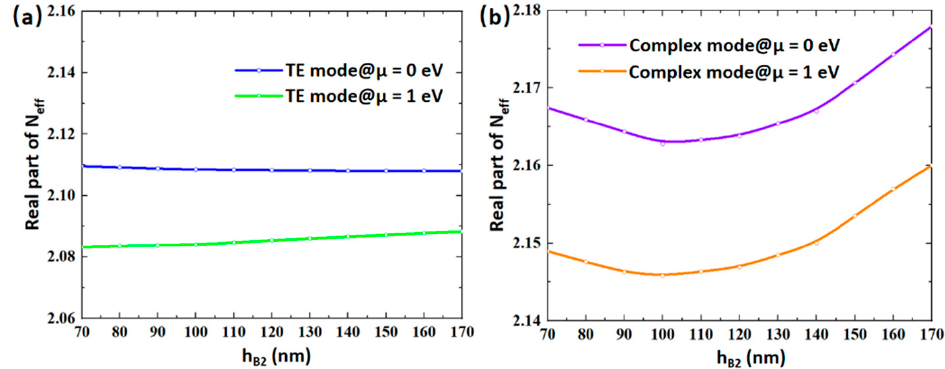
Figure 14. Re( N eff ) as a changing relationship of h B2 for ( a ) TE mode and ( b ) complex mode.